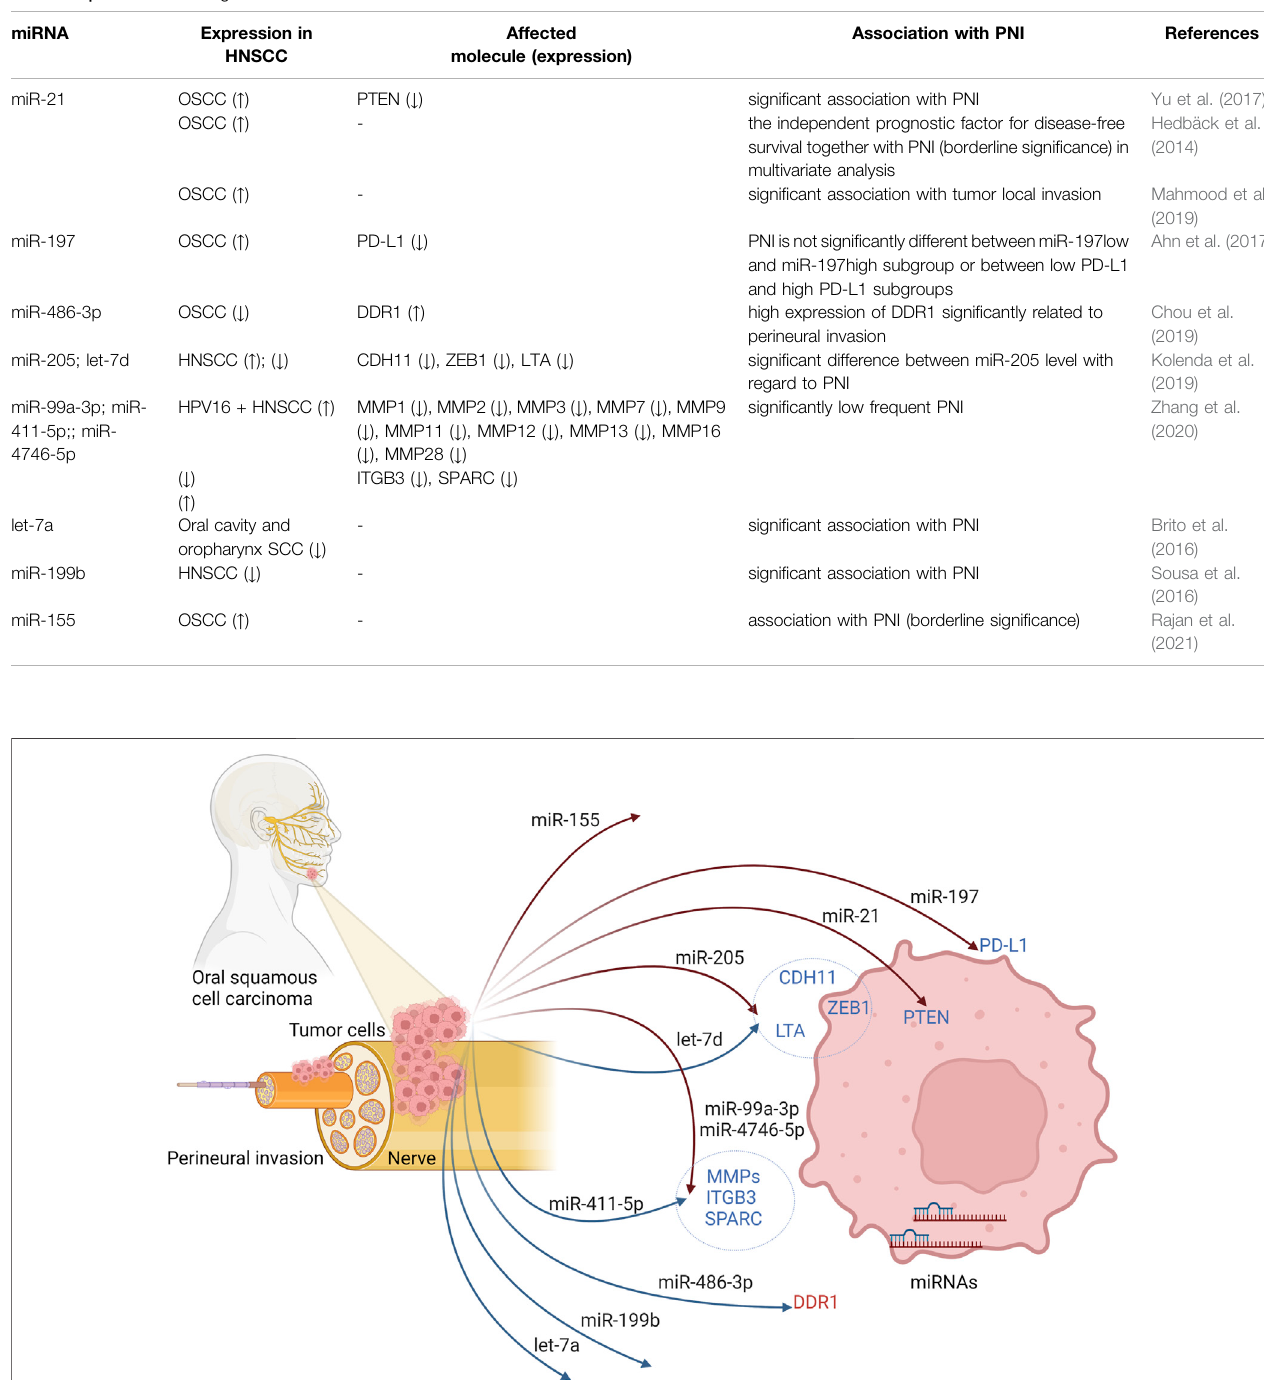
Frontiers in Genetics |